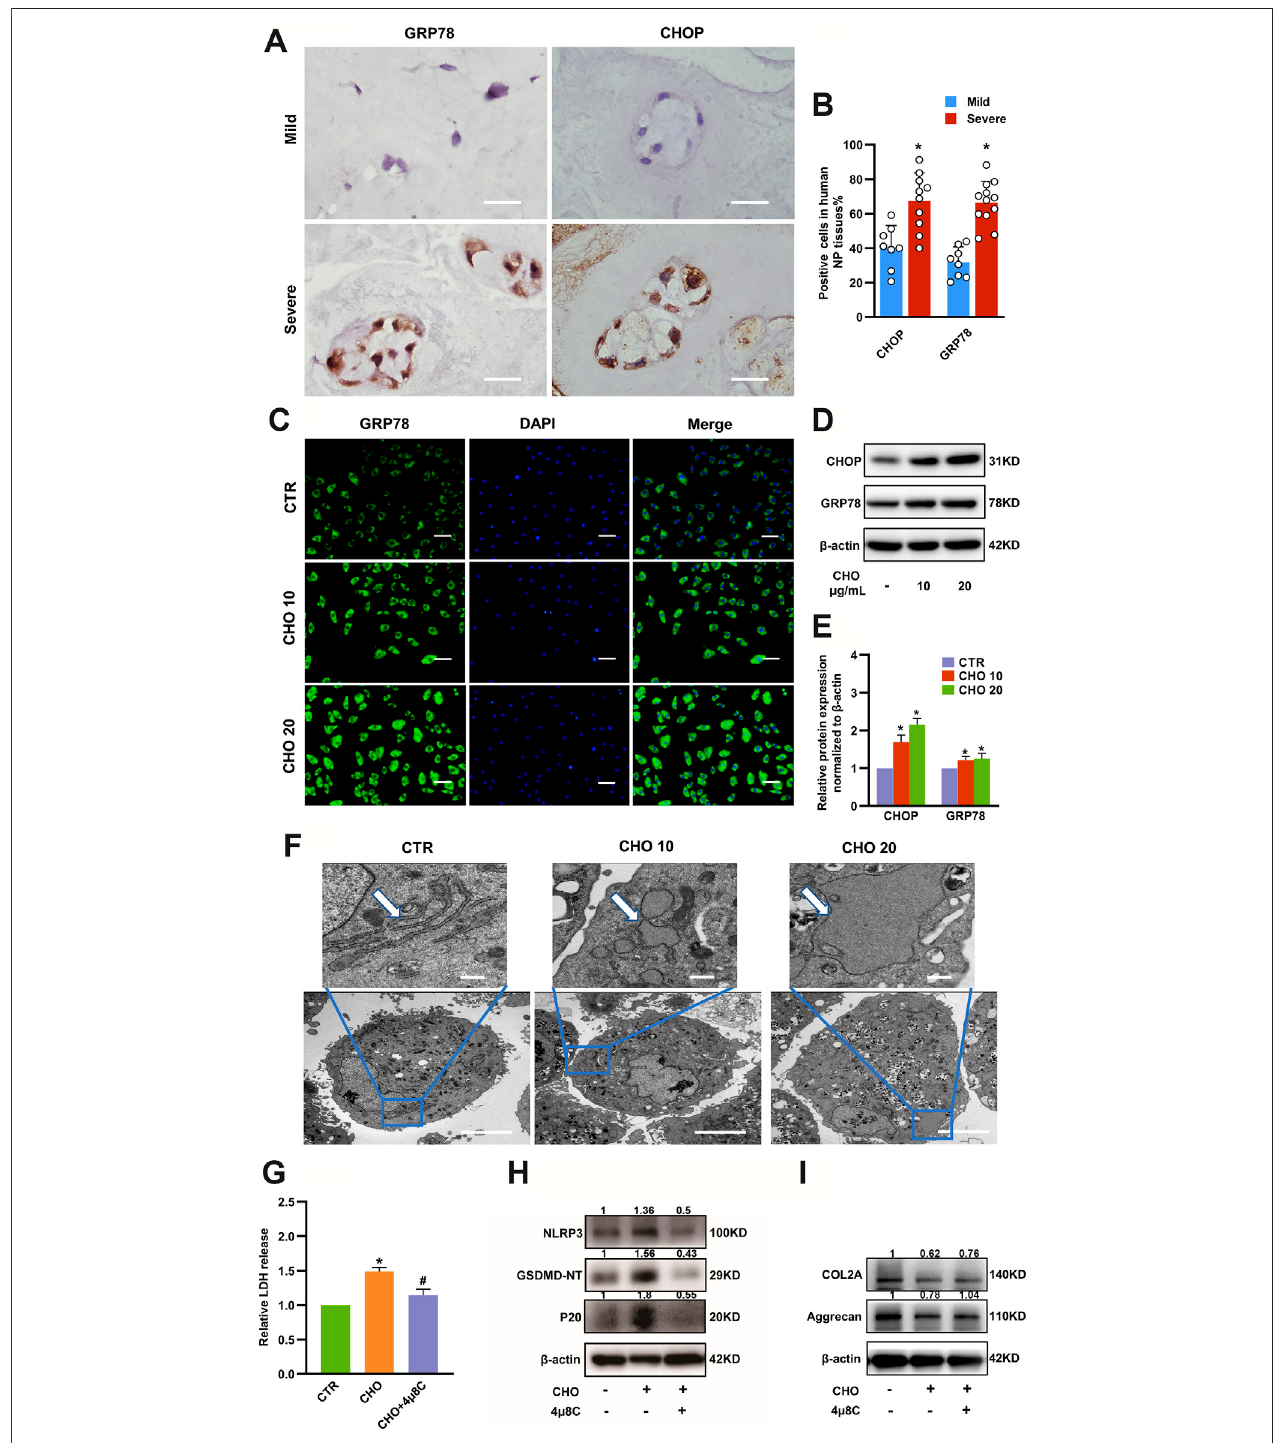
FIGURE 5 | ER stress plays a critical role in cholesterol-induced pyroptosis and matrix degradation in NP cells. (A) Representative images of GRP78 and CHOP staining in mild and severe degenerative NP tissues, as determined by IHC (bar (cid:1) 20 μ m). (B) Quanti fi cation of positive cells showing increased expressions of GRP78 and CHOP in severely degenerative NP tissues (n (cid:1) 8 – 12). (C) Immuno fl uorescence images of NP cells stimulated with cholesterol and stained with an antibody against GRP78(bar (cid:1) 100 μ m). (D,E) ProteinexpressionlevelsofGRP78andCHOPwereupregulated,asrevealedbyimmunoblottingandsubsequentquanti fi cation(n (cid:1) 3). (F) TEM images of NP cells. Control cells showed slender tube-like rough ERs. Cholesterol-stimulated cells featured swelling and enlarged rough ERs (upper panel, bar (cid:1) 500 nm; lower panel, bar (cid:1) 5 μ m). (G) 4 μ 8C (20 μ M) suppressed cholesterol (10 μ g/ml) induced LDH increase in the culture supernatants of NP cells (n (cid:1) 3). (H)